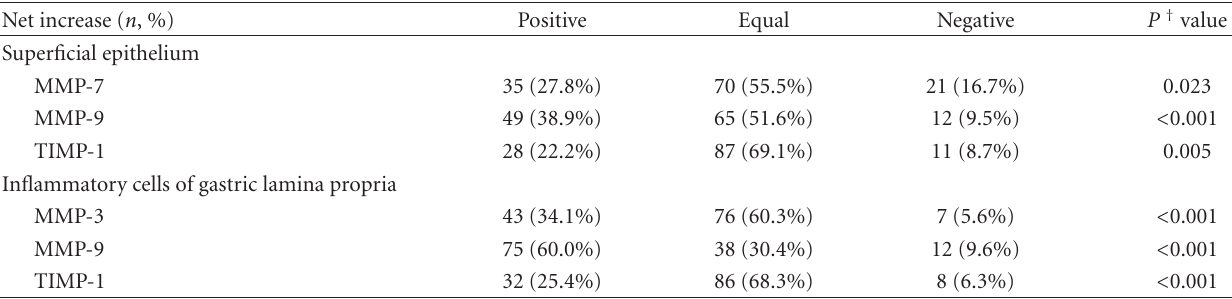
Table 2: The distributions of MMP-3, -7, and -9 and TIMP-1 net over di ff erent histologic locations of gastric ulcer tissues compared to non-ulcer